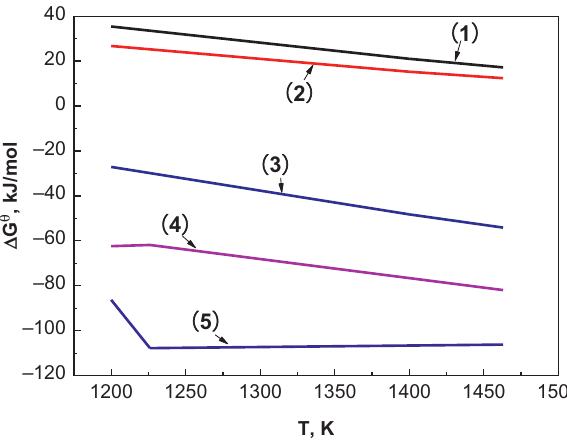
Table 3: Industrial analysis results of bituminous coal (mass/%). Fixed carbon